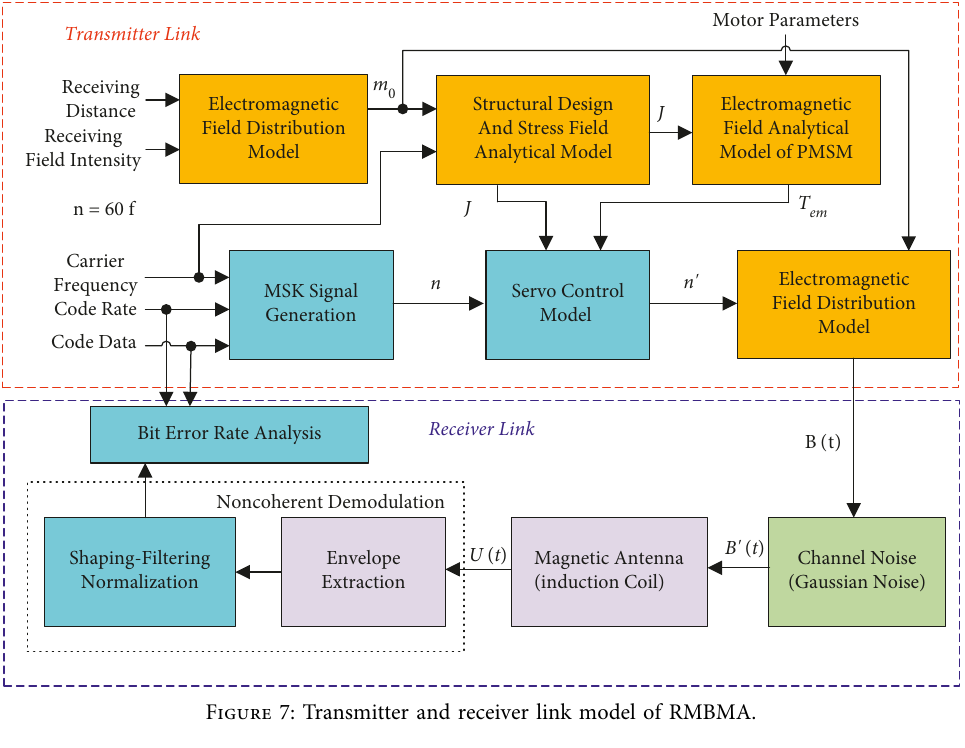
Figure 7: Transmitter and receiver link model of